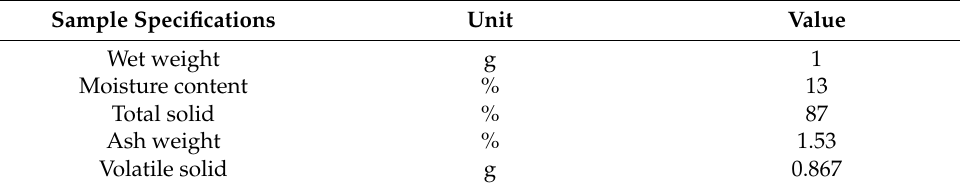
Table 2. Date seed powder sample